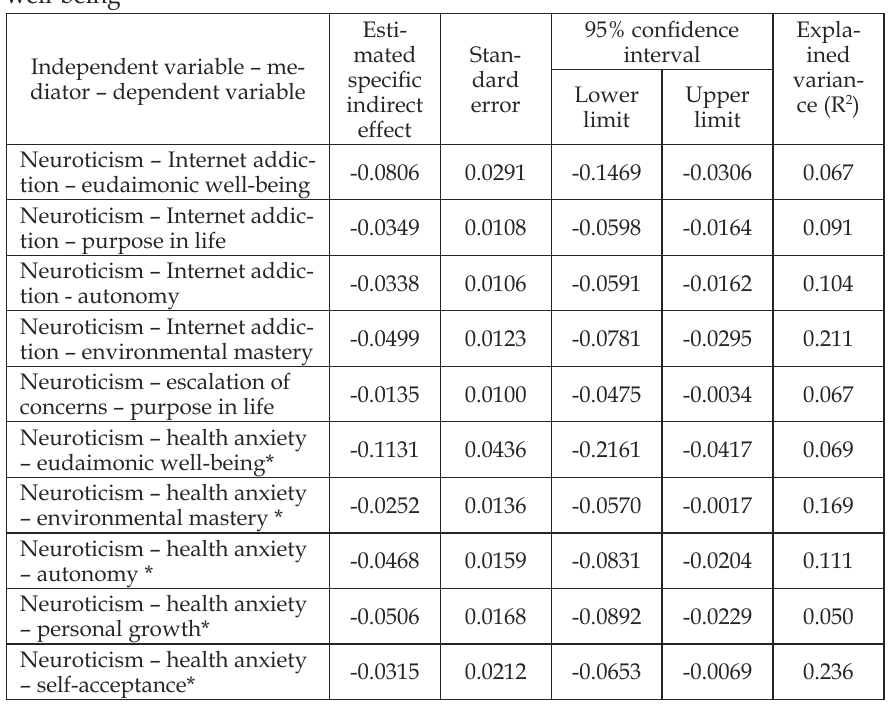
Tab. 1. Signi (cid:222) cant indirect effects with independent variable Neuroticism